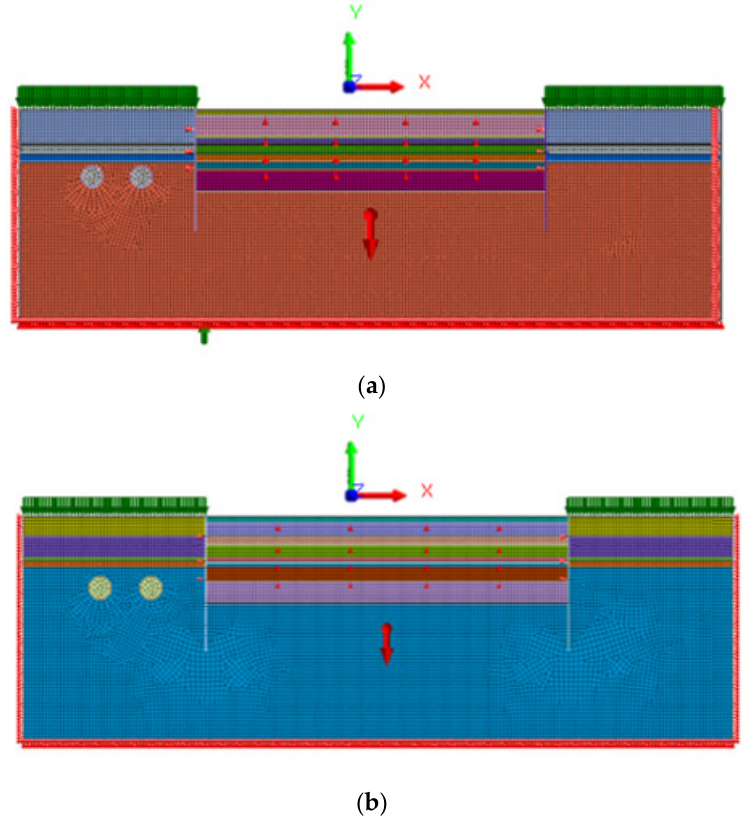
Figure 7. Meshing diagram of finite element model. ( a ) Finite element model of section A of the foundation pit. ( b ) Finite element model of section B of the foundation pit.